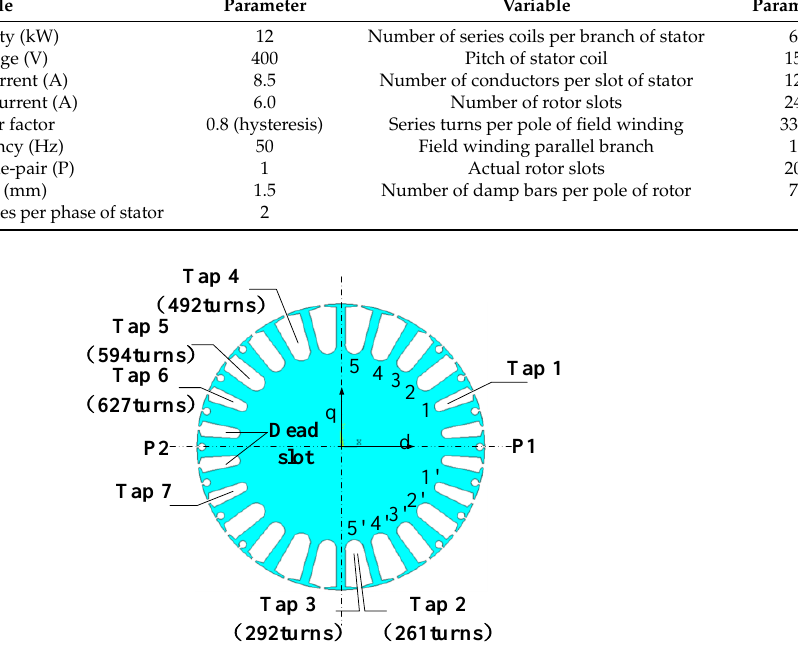
Figure 6. Rotor lamination and field winding’s taps of A1552 model machine. Table 1. Parameters of A1552 non-salient pole model machine.